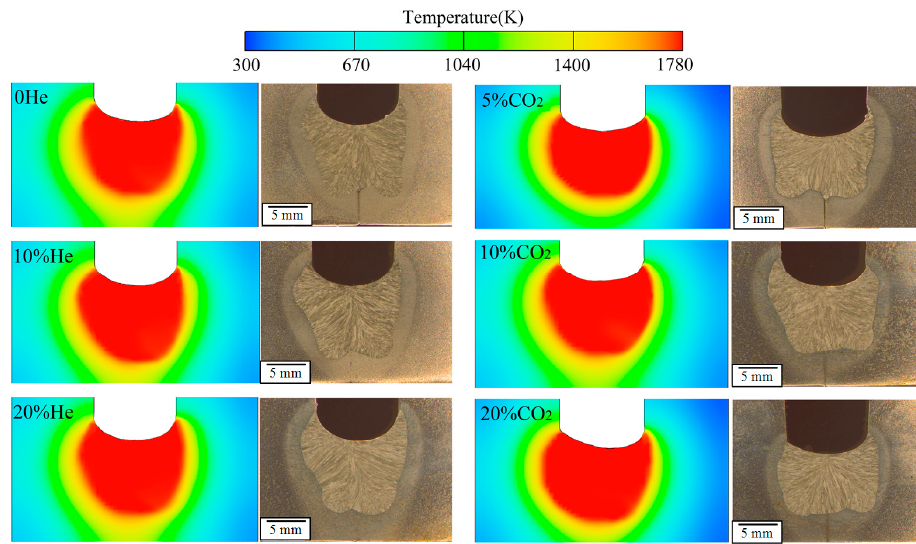
Figure 8. Calculated molten pool temperature fields and the corresponding measured weld shapes; the CO 2 content is 10% in the left-hand figures and the He content is 5% in the right-hand figures.